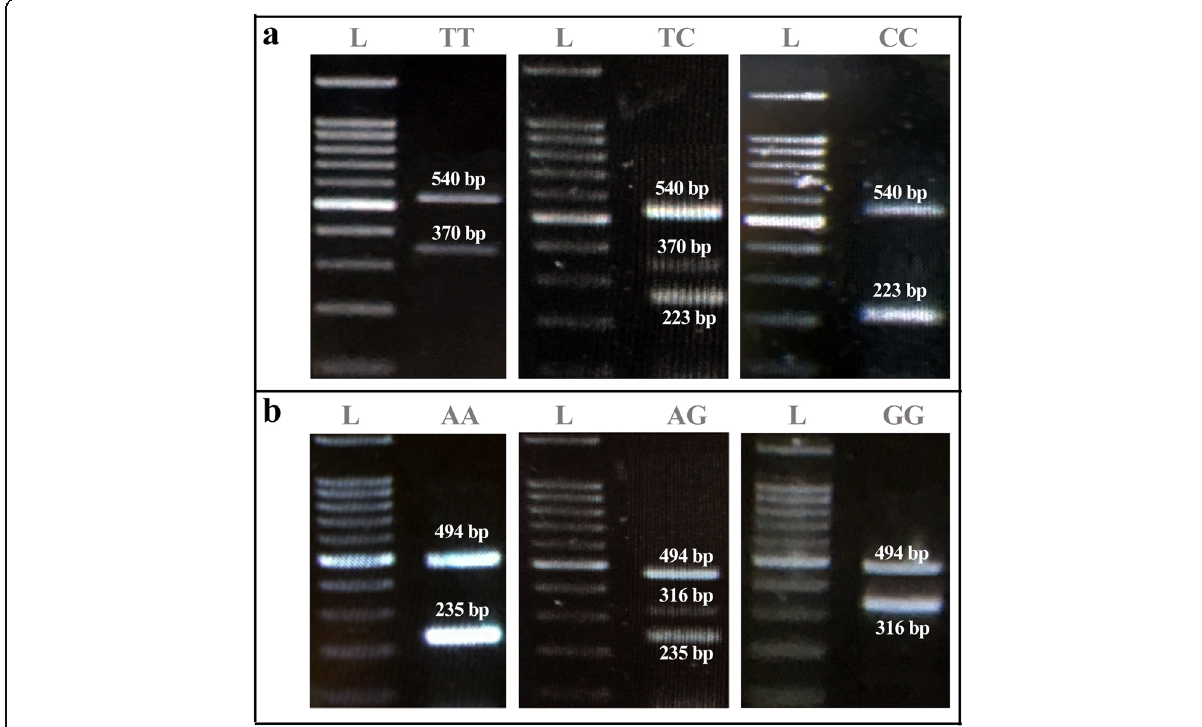
Fig. 1 The PCR products of rs8177404 and rs3828599 GPX3 gene polymorphisms on 1.5% agarose gel using tetra-primer ARMS-PCR. a The presence of two bands with a length of 540bp and 370bp, and length of 540bp and 223bp and three fragments (540bp, 370bp, and 223bp) were referred as the TT, CC, and TC genotypes of rs8177404 polymorphism, respectively. b The presence of two bands with a length of 494bp and 235bp, and length of 494bp and 316bp and three fragments (495bp, 316bp, and 235bp) were referred as the AA, GG, and AG genotypes of rs3828599 polymorphism, respectively. L, DNA